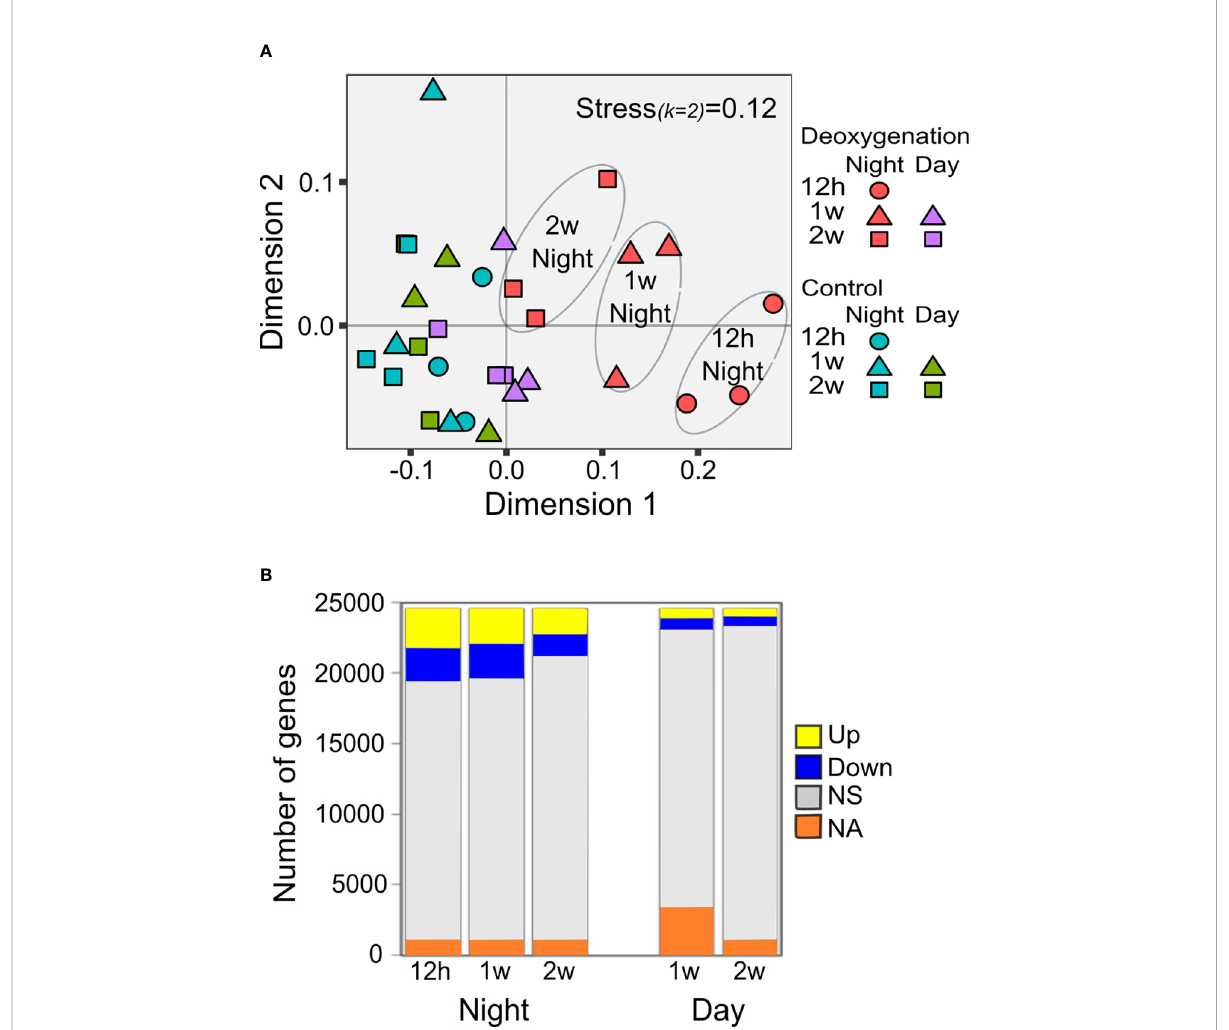
FIGURE 2 Transcriptional response to deoxygenation. (A) Non-metric multidimensional scaling analysis (NMDS)-based ordination presenting dissimilarity between transcriptomes of S. pistillata placed under control or constant deoxygenation. Corals were sampled at night and day, after 12 hours, one week, and two weeks from the onset of deoxygenation (n=3).Bray-Curtis distance matrix using log 10 FPKM-based Bray-Curtis distances. (B) Total counts of H vs C up/down-regulated DE genes between comparable time-points (same daytime, same week). NS- not signi fi cant, NA- not applicable for statistical analysis (Data